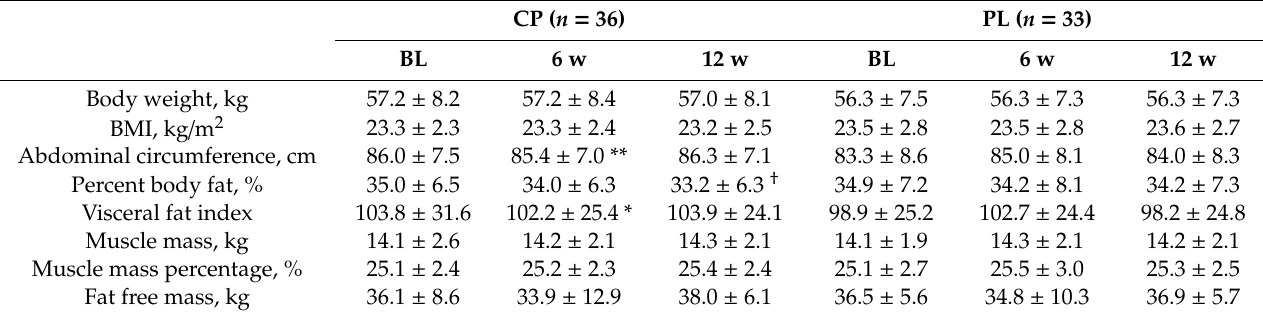
Table 5. Physical attributes in all